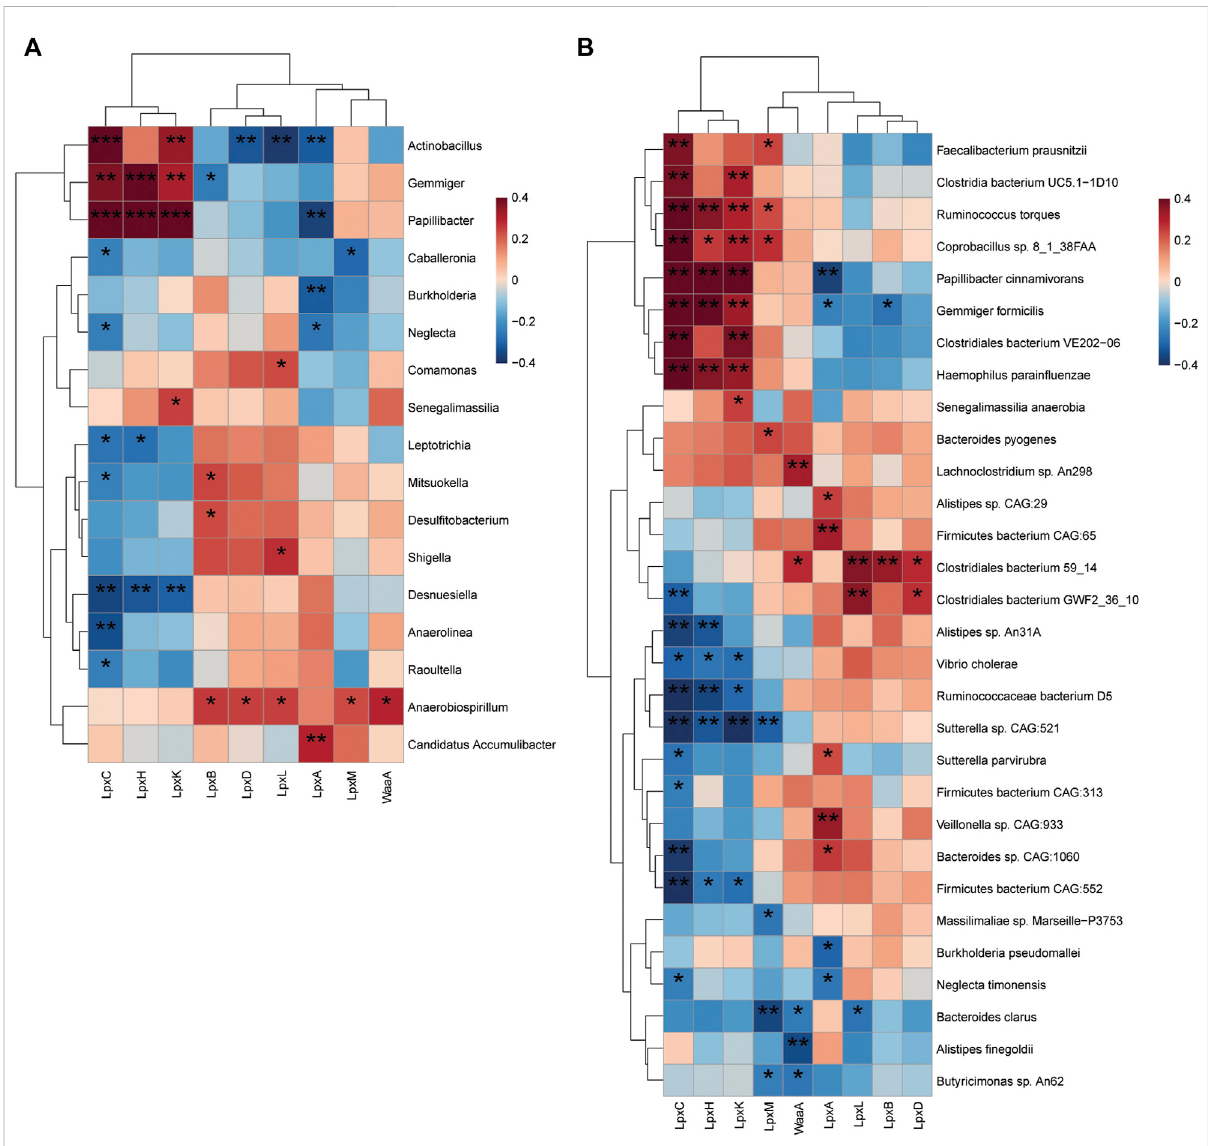
FIGURE 6 Correlation of LPS-biosynthesis-related enzymes and harboring gut bacteria. (A) Spearmen correlation analysis of the relationship between potential LPS-producing genera (22 bacteria discriminative in patients with T2D and individuals with NGT) and enzymatic genes. Statistical differences in correlation coef fi cients between LPS-producing genus and one of the enzyme genes were shown (B) Heat map depicts the association betweenLPS-biosynthesis-related enzymes and top 30 altered species harboring enzymatic genes. Blue, negative correlation; red, positivecorrelation;* p < 0.05;** p < 0.01;*** p < 0.001.Correlationwith p ≥